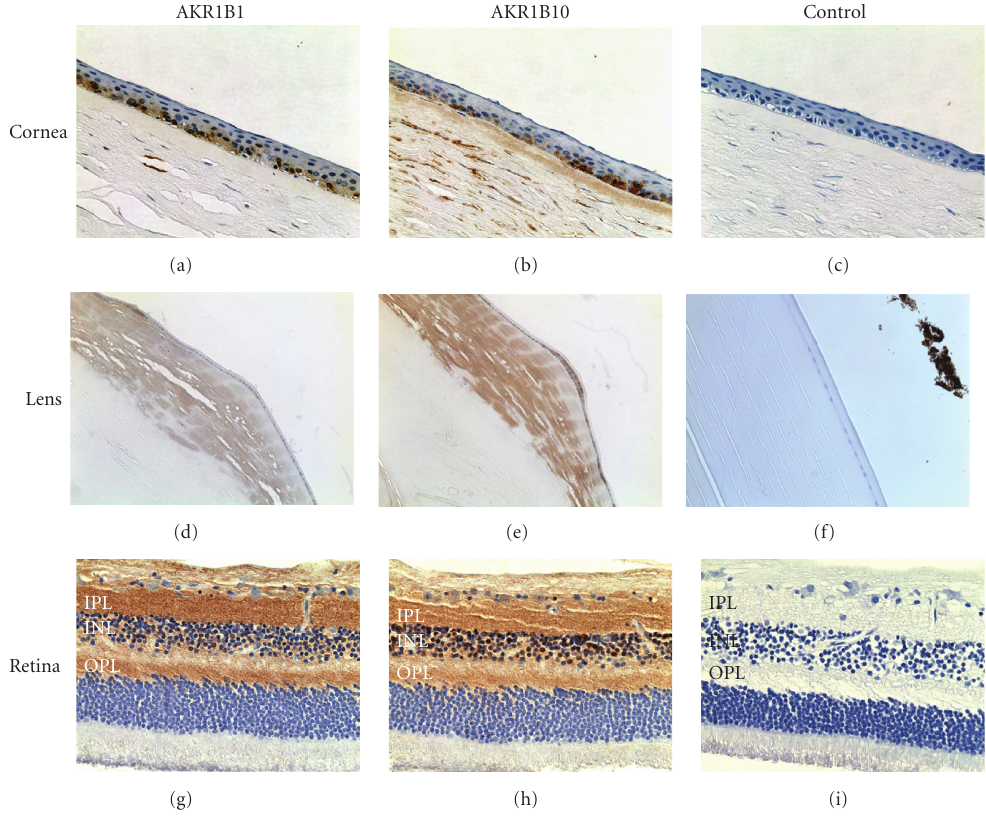
Figure 2: Immunostaining for AKR1B1 and AKR1B10 in human eye tissues. A donor eye (77-year-old male) was treated with antibodies to AKR1B1 and AKR1B10 or preimmune control serum. Immune complexes were visualized by treatment with a horseradish peroxidase- conjugated secondary antibody and signal developed using diaminobenzidine tetrahydrochloride (DAB) to give a brown color. Tissues examined include cornea (a)–(c), lens (d)–(f), and retina (g)–(i). Immunostaining was particularly strong in the inner plexiform (IPL) and outer plexiform (OPL) layers. The inner nuclear layer is shown (INL).